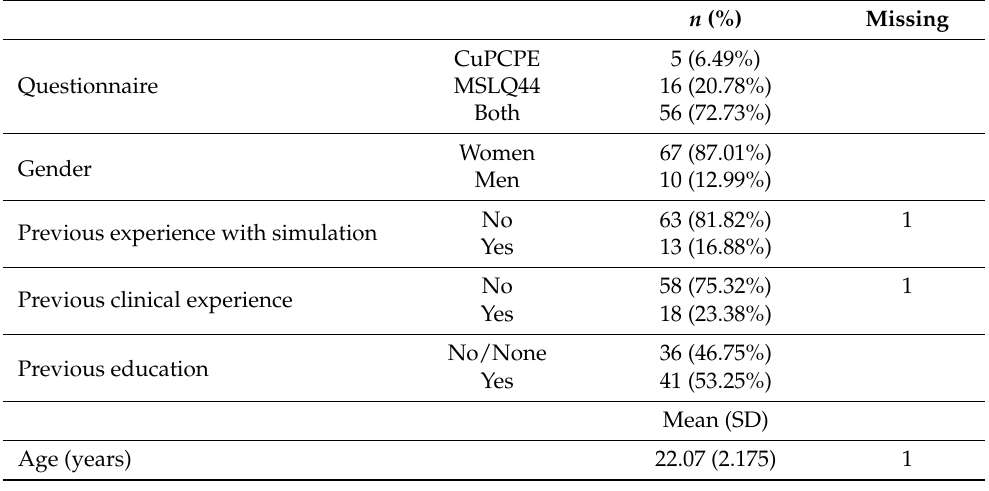
Table 1. Overview of demographic variables ( n = 77).